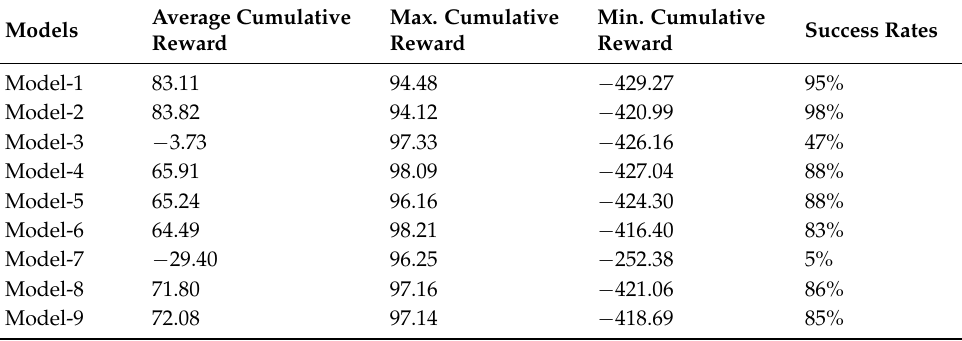
Figure 8. Training Results ALL Models. Table 4. DRL Models Training Rewards